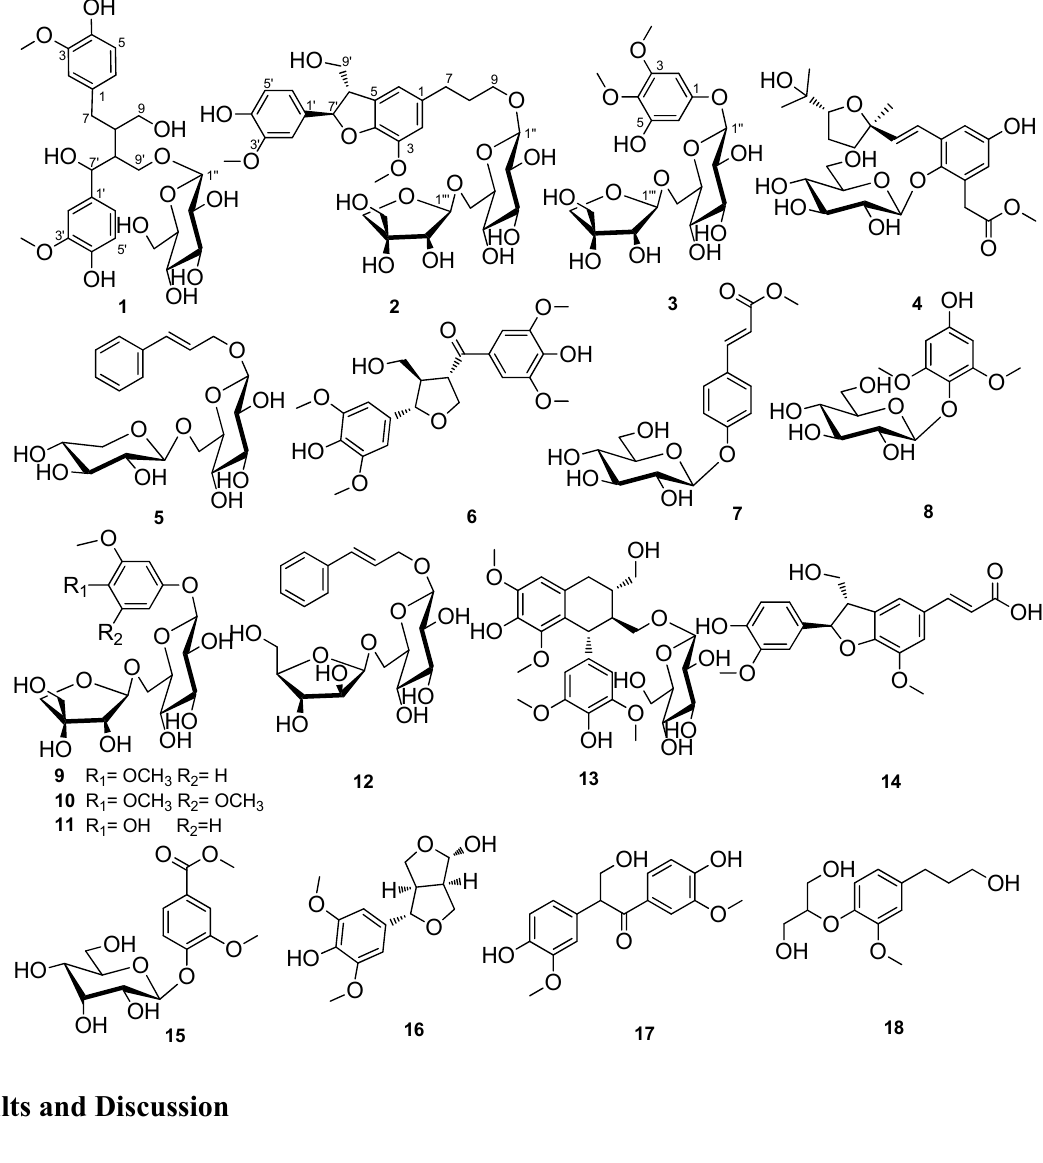
Figure 1. Structures of compounds 1 – 18